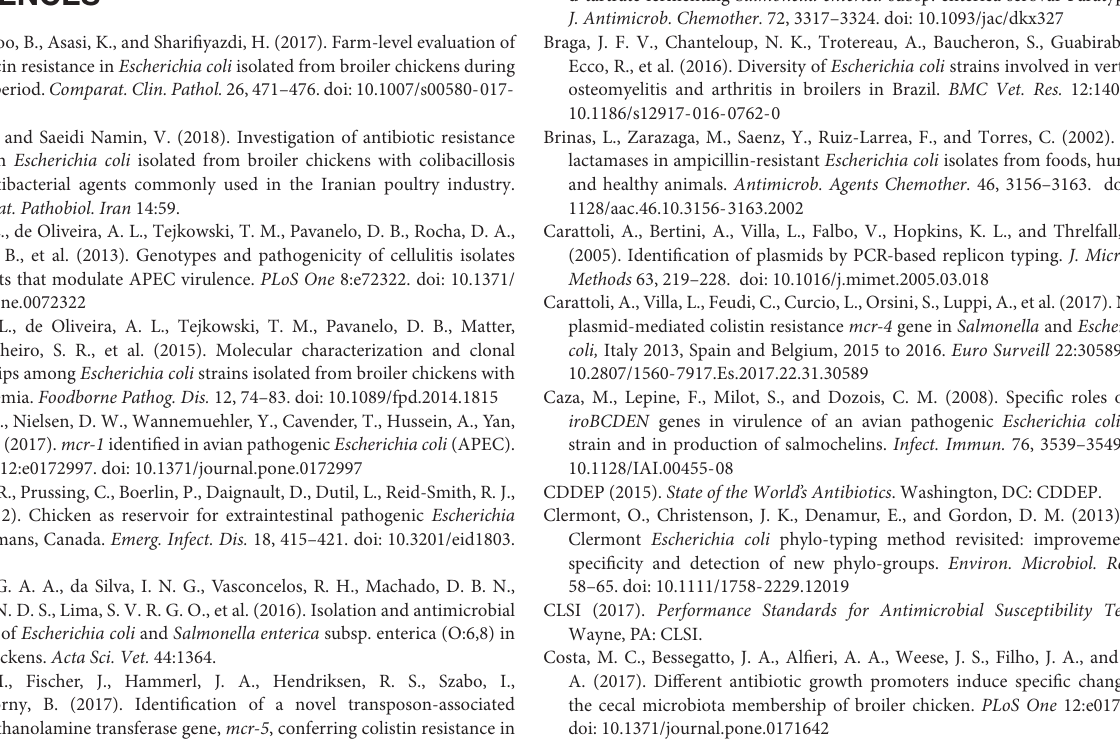
Supplementary Table 3C | Antimicrobial resistance profiles.